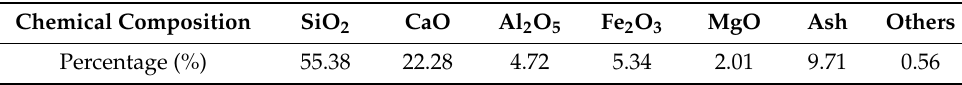
Table 3. Main chemical composition of